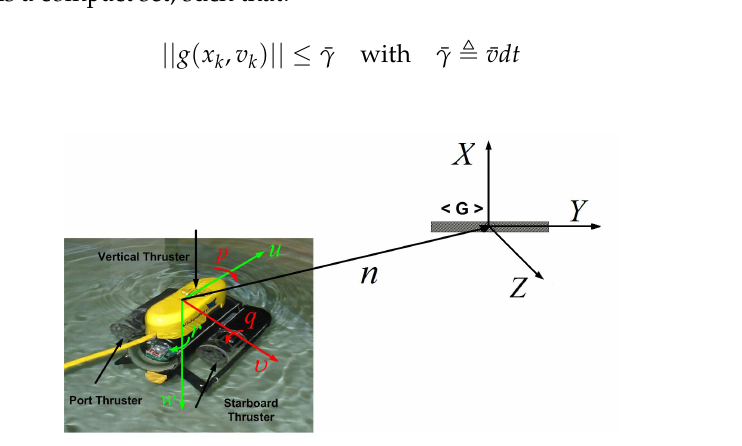
Figure 3. System coordination. The under-actuated, as well as the actuated, degrees of freedom are indicated with red and green color, respectively, c (cid:13) 2014 IEEE